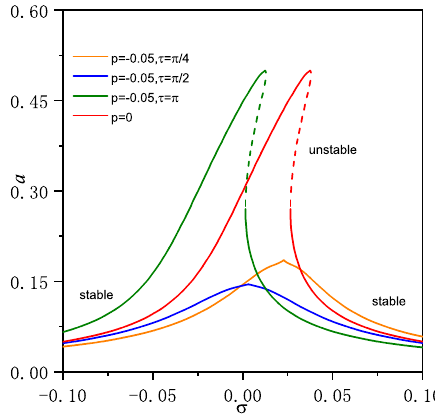
Figure 12. Frequency response curves showing the primary resonances response of the nonlinear beam with time delayed acceleration feedback.